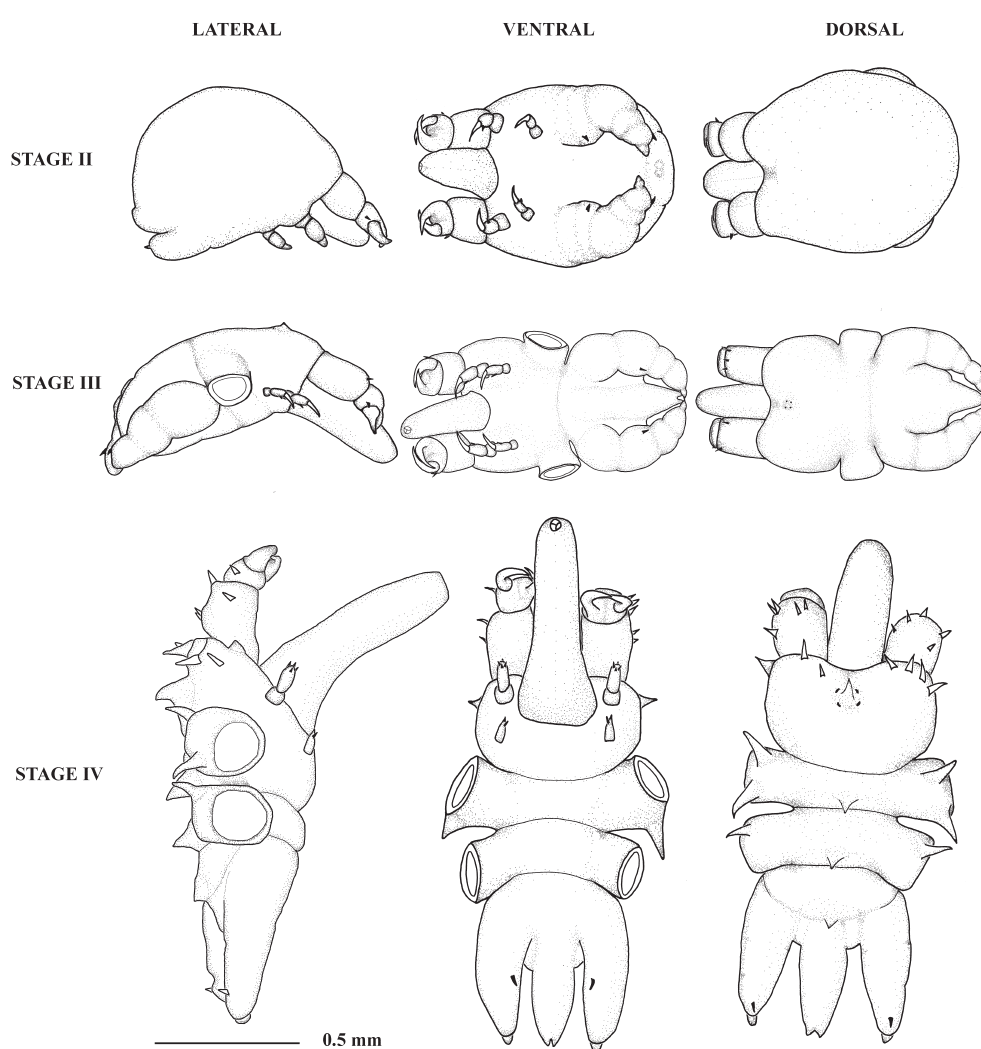
Fig . 1. – larvae of Ammothea glacialis (Hodgson, 1907). lateral, ventral and dorsal view of the three instar larvae (which is developing on the appendages of the